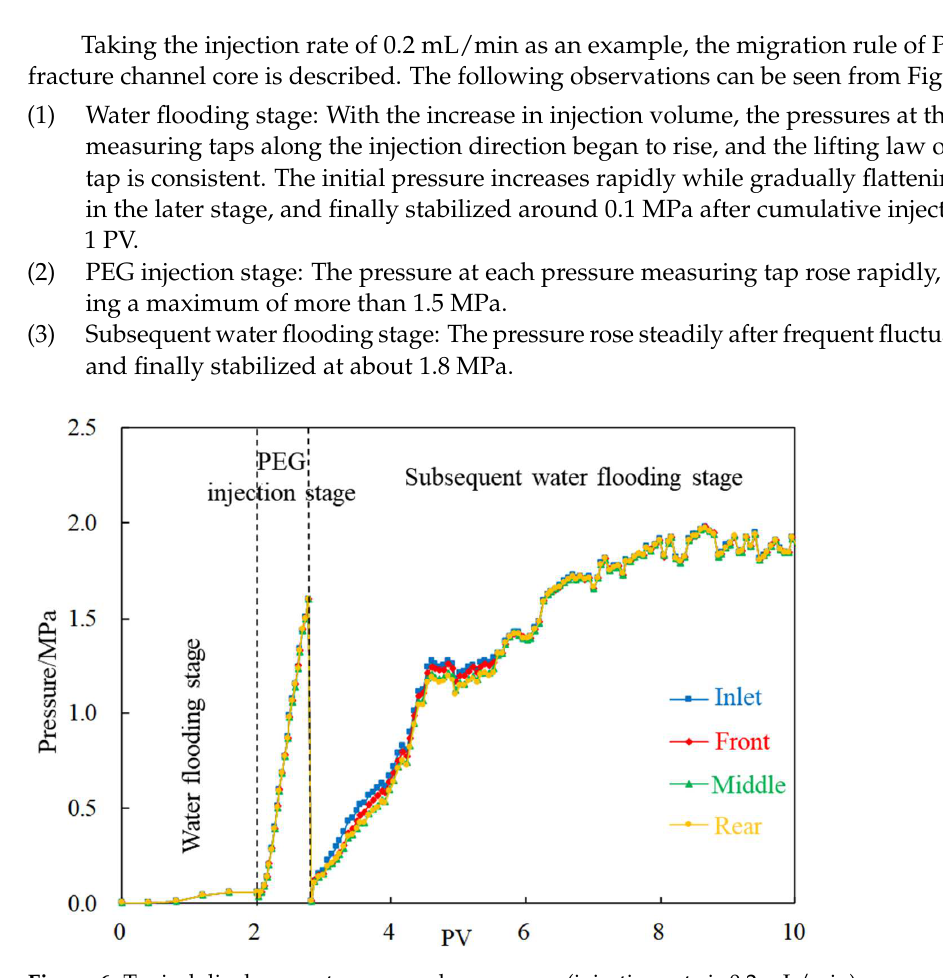
Figure 7. Pressure change curve (injection rate is 0.1 mL/min).